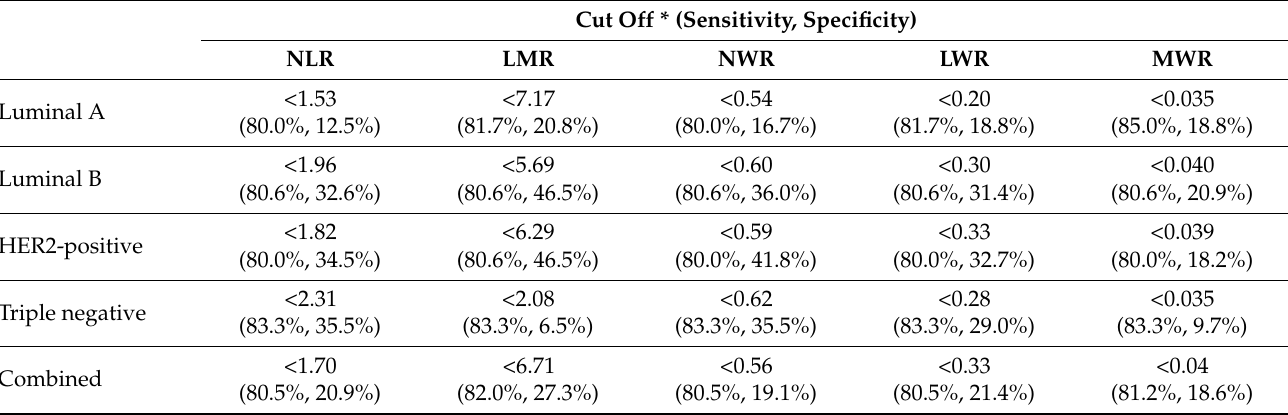
Table 5. Optimal immunocyte ratio cut-off values by cancer subtype for 3-year OS. Cut Off * (Sensitivity,